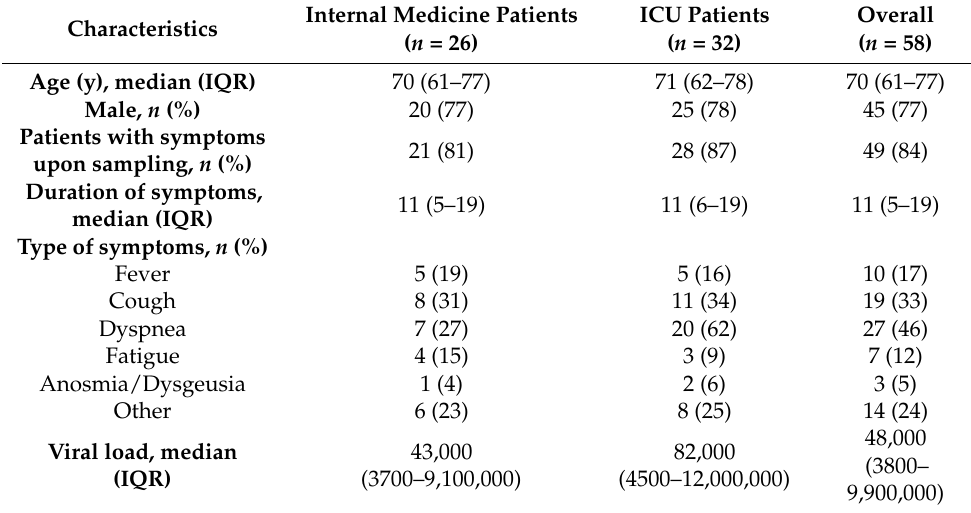
Table 1. Baseline demographics and clinical characteristics of patients.